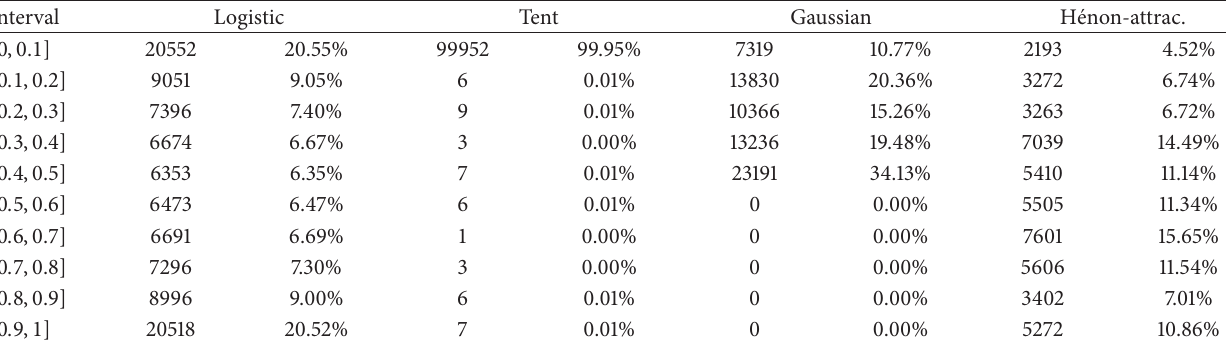
Table 5: System output total number and its percentage in each interval of logistic map, tent map, Gaussian map, and H´enon map with attractor initiation after 10 5 iterations. The output of H´enon map with random initiation is out of the interval (0, 1]